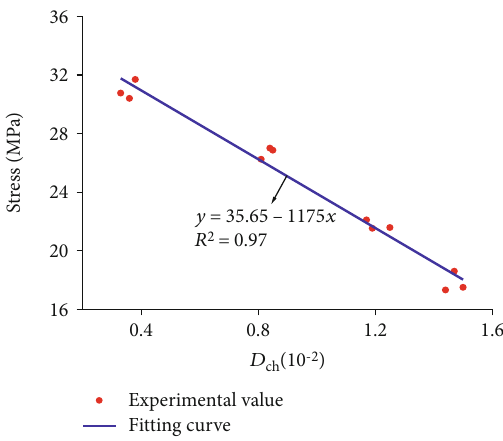
Figure 9: Chemical damage parameters and peak